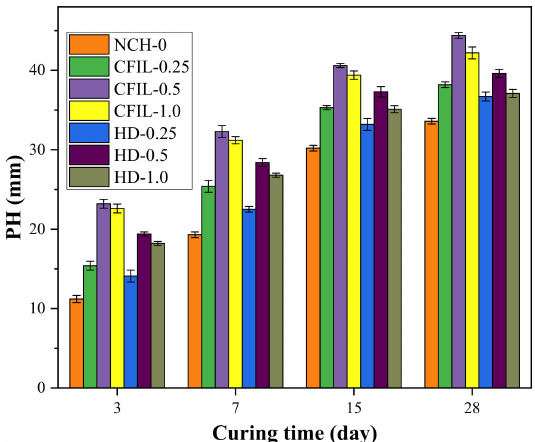
Figure 15. Relationship between penetration height (PH) and curing time.